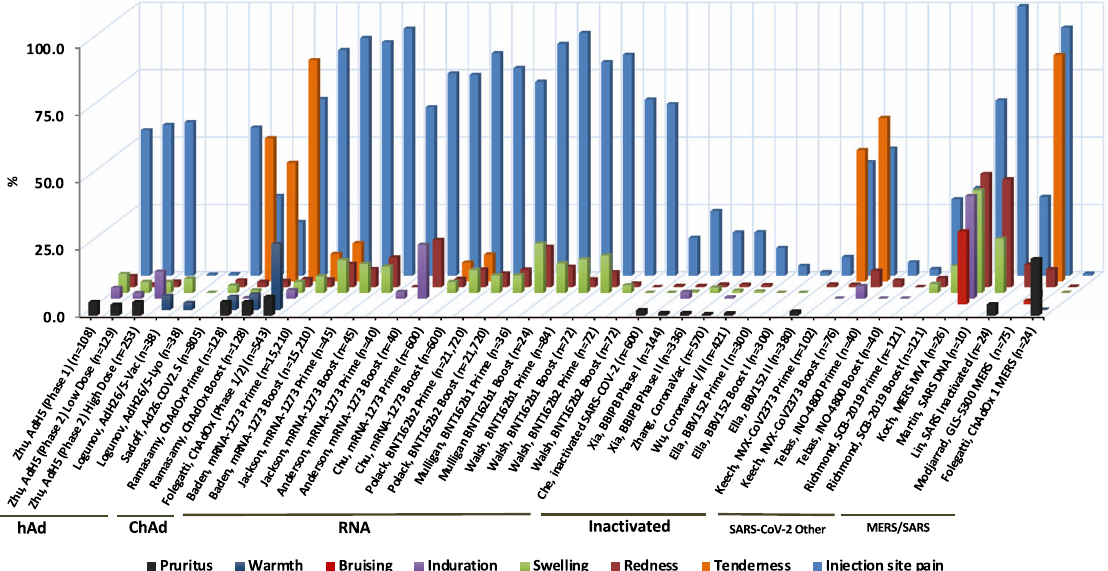
Fig. 3 Interstudy analysis of local adverse events reported in vaccine group (excluding control group) of coronavirus vaccine studies. Symptoms are represented by different colors. The percent (%) of vaccines reporting any grade of AE is shown. First author and vaccine platform are recorded on the X axis. hAd human adenoviral, ChAd chimpanzee